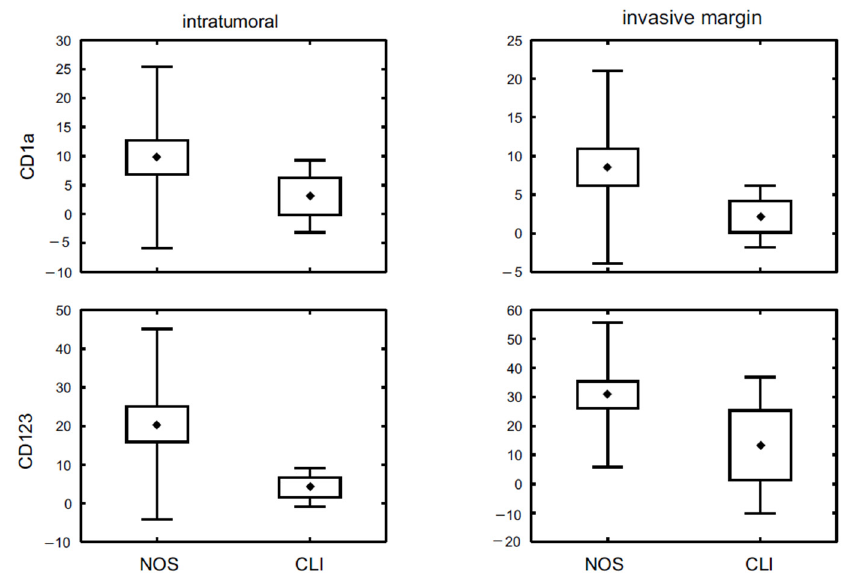
Figure 3. The density of CD1a+ and CD123+ DC populations in breast cancer specimens representing different histologic type: NOS—invasive carcinoma not otherwise specified, CLI—invasive lobular carcinoma. Central point is the arithmetic mean, box is the arithmetic mean ± 2 × standard error and whisker is the arithmetic mean ± 0.95 × standard deviation.